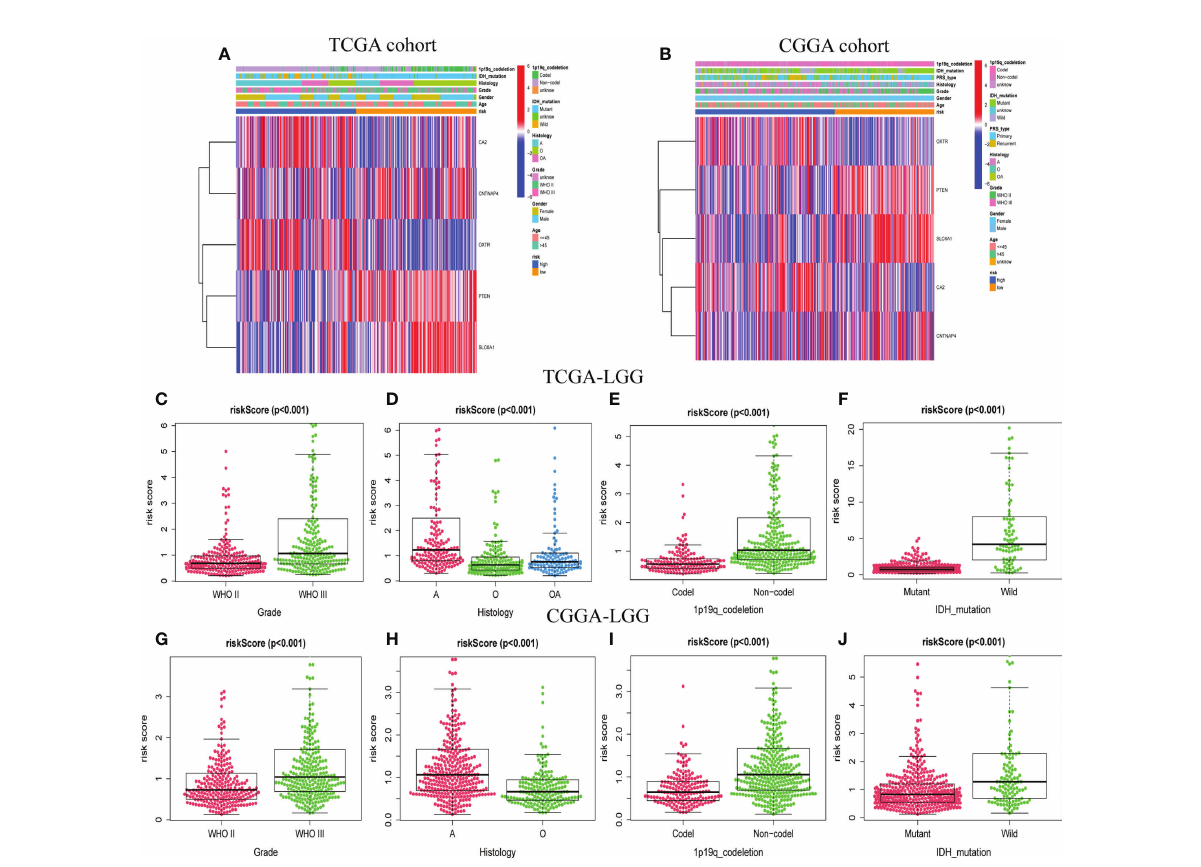
FIGURE 4 The association between risk score and clinicopathological factors. Heatmap of the correlations between risk score and clinicopathological characteristics of LGG in TCGA (A) and CGGA (B) cohorts. Distribution of GABAergic synapses-related risk signature among LGG patients strati fi ed by WHO grade, histology, IDH status, 1p/19q co-deletion status, and gender in TCGA (C – F) and CGGA (G – J)